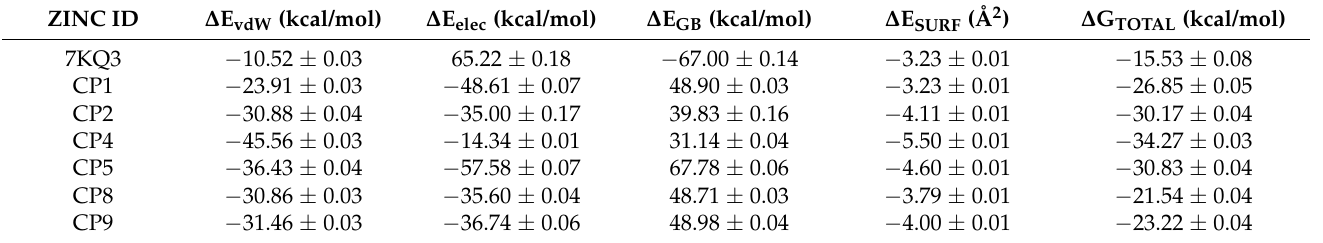
Table 2. Binding free energy calculations of selected compounds and substrate–Isla complexes.